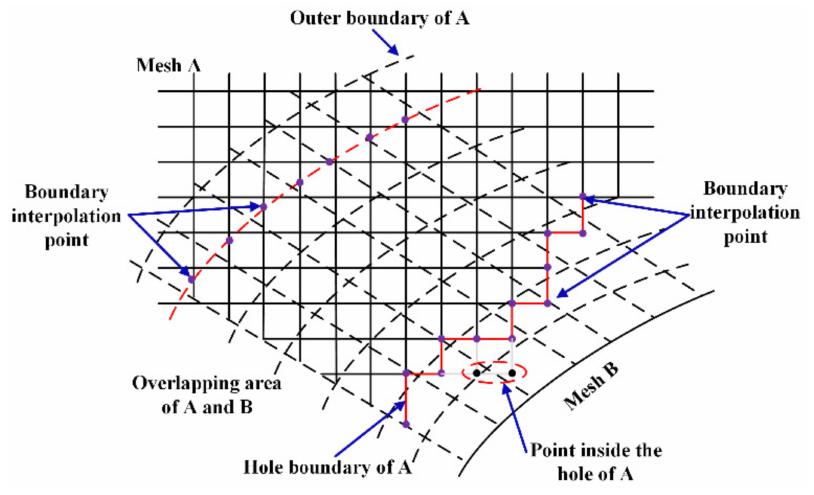
Figure 1. Schematic of overset